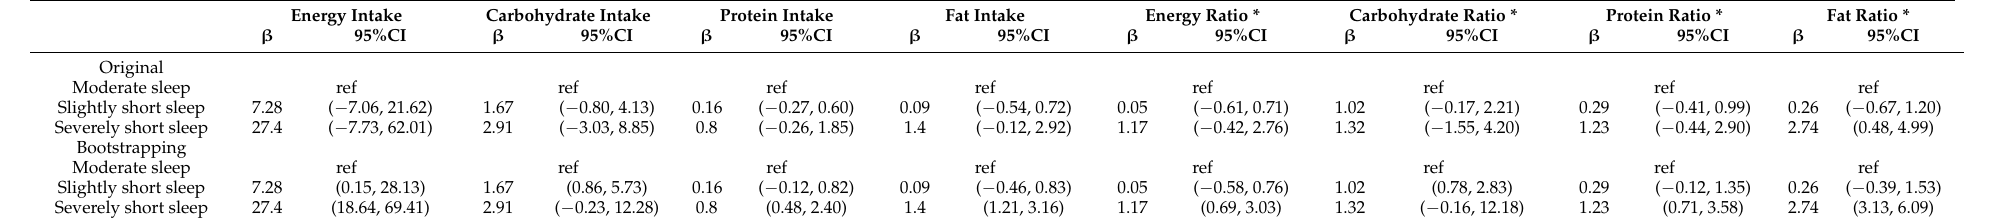
Table 5. Linear regression between sleep duration and energy and macronutrient intake from